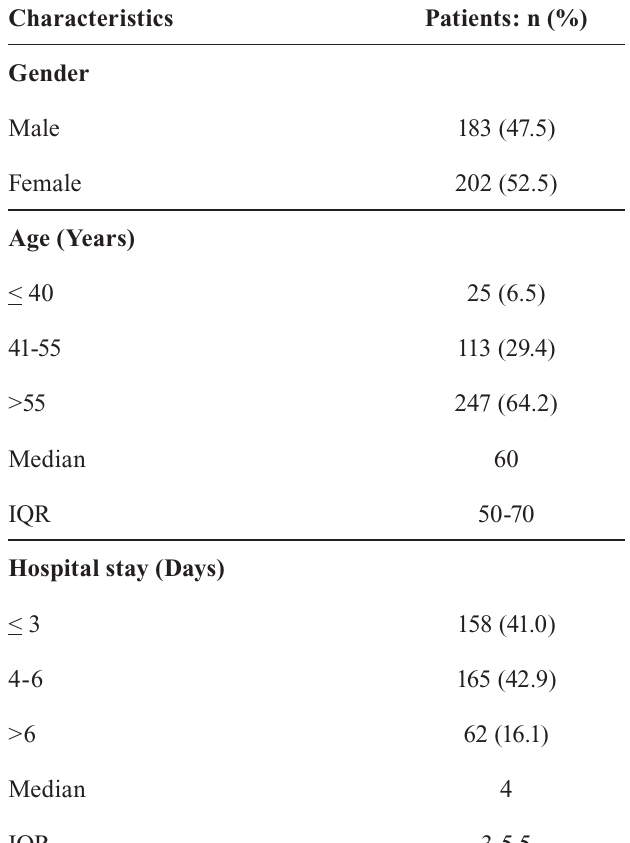
TABLE I - G eneral characteristics of study subjects